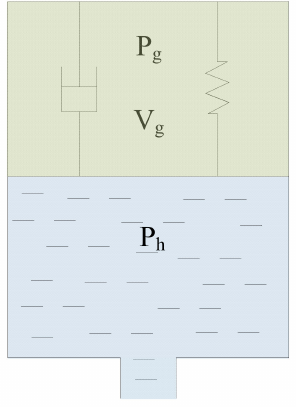
Figure 7. Function diagram of the